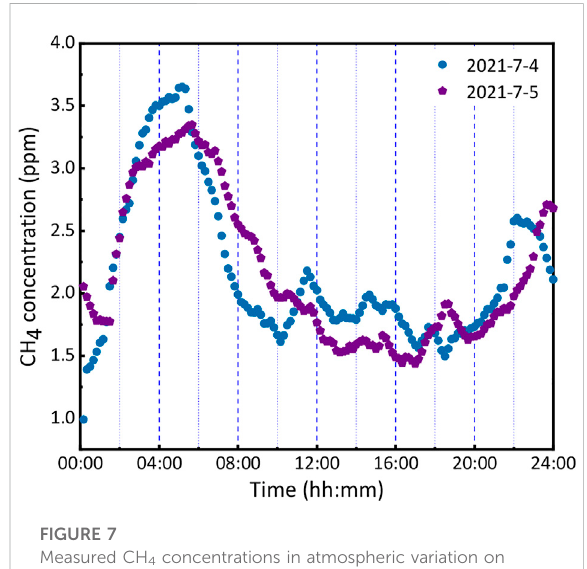
FIGURE 7 Measured CH 4 concentrations in atmospheric variation on 2021-7-4(Sunday) and 2021-7-5